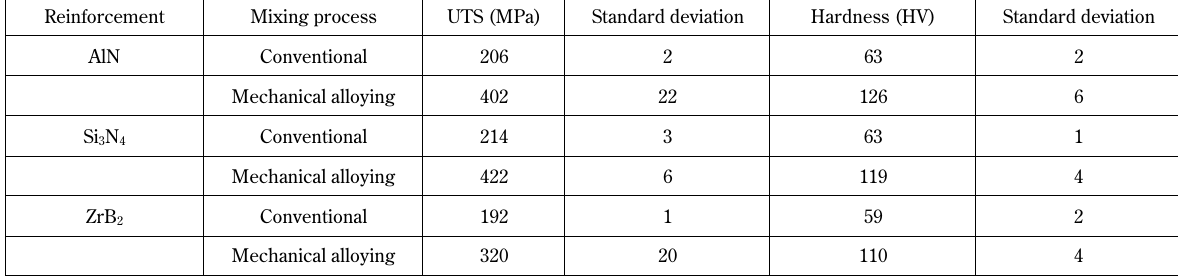
Table 5 Ultimate tensile strength and hardness of the composite